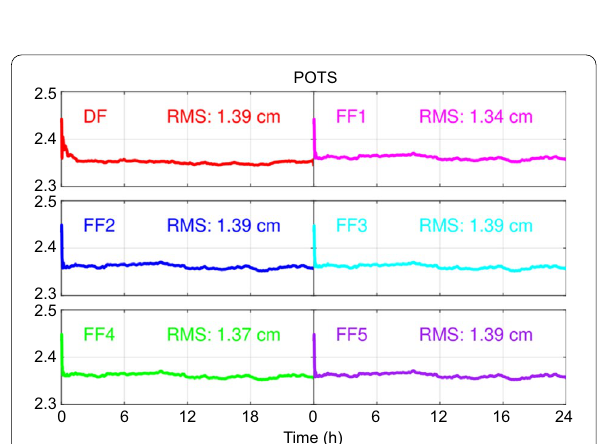
Fig. 8 Boxpolt of the convergence time with different models for the selected 20 stations